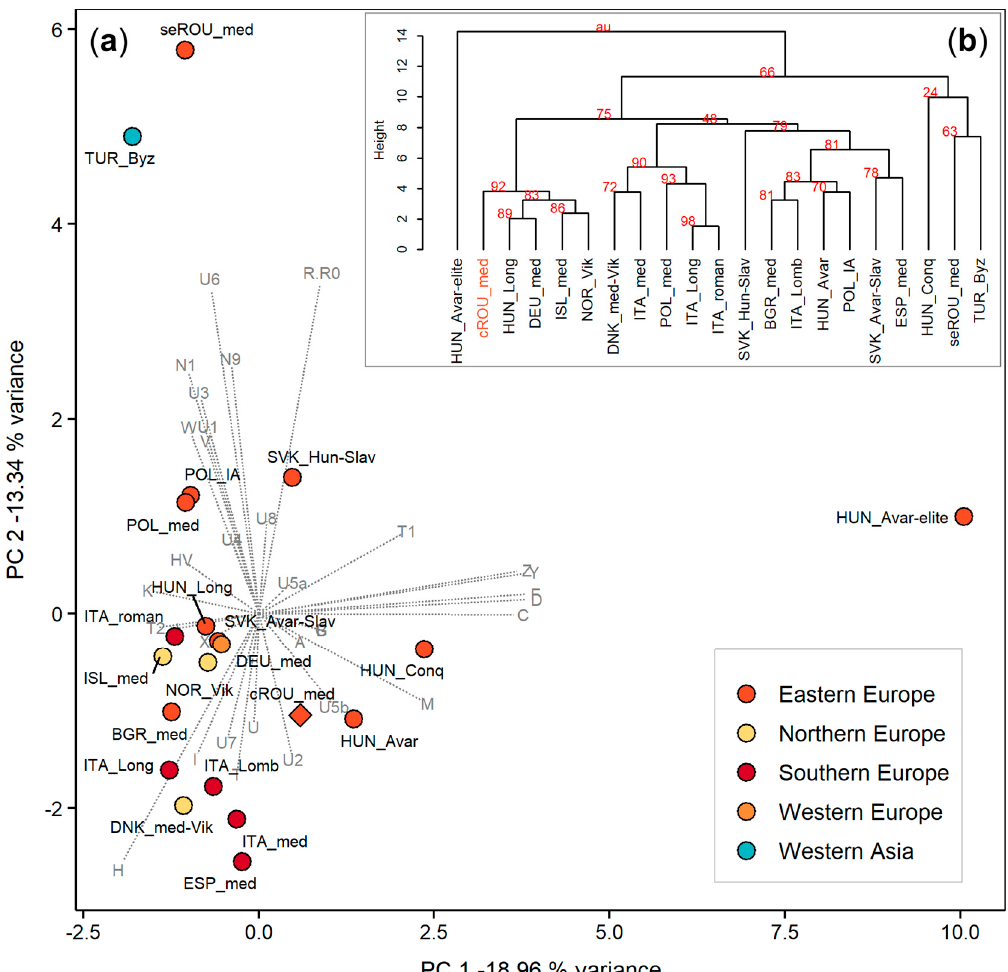
Figure 2. Haplogroup-based analyses of 21 historical populations. ( a ) PCA plot of the first two principal components; ( b ) Ward type hierarchical clustering (AU p -values in percent are given as red numbers on the dendogram). The investigated population from Feldioara (cROU_med) is clustered with early medieval individuals from Bavaria (DEU_med), Longobards from Hungary (HUN_Long), Vikings from Norway (NOR_Vik), and Early medieval Icelanders (ISL_med). This cluster is distinct from the one formed by mid-Byzantine population from southwestern Anatolia (TUR_Byz) and a medieval population from southeastern Romania (seROU_med). Abbreviations and mtDNA haplogroup frequencies are reported in Table